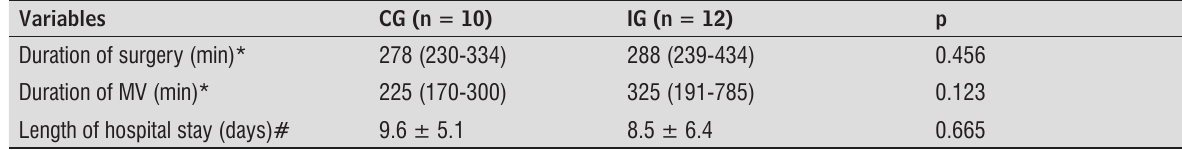
Table 3 - Duration of the surgical procedure and mechanical ventilation and length of hospital stay after surgery Variables CG (n = 10) IG (n = 12) Duration of surgery